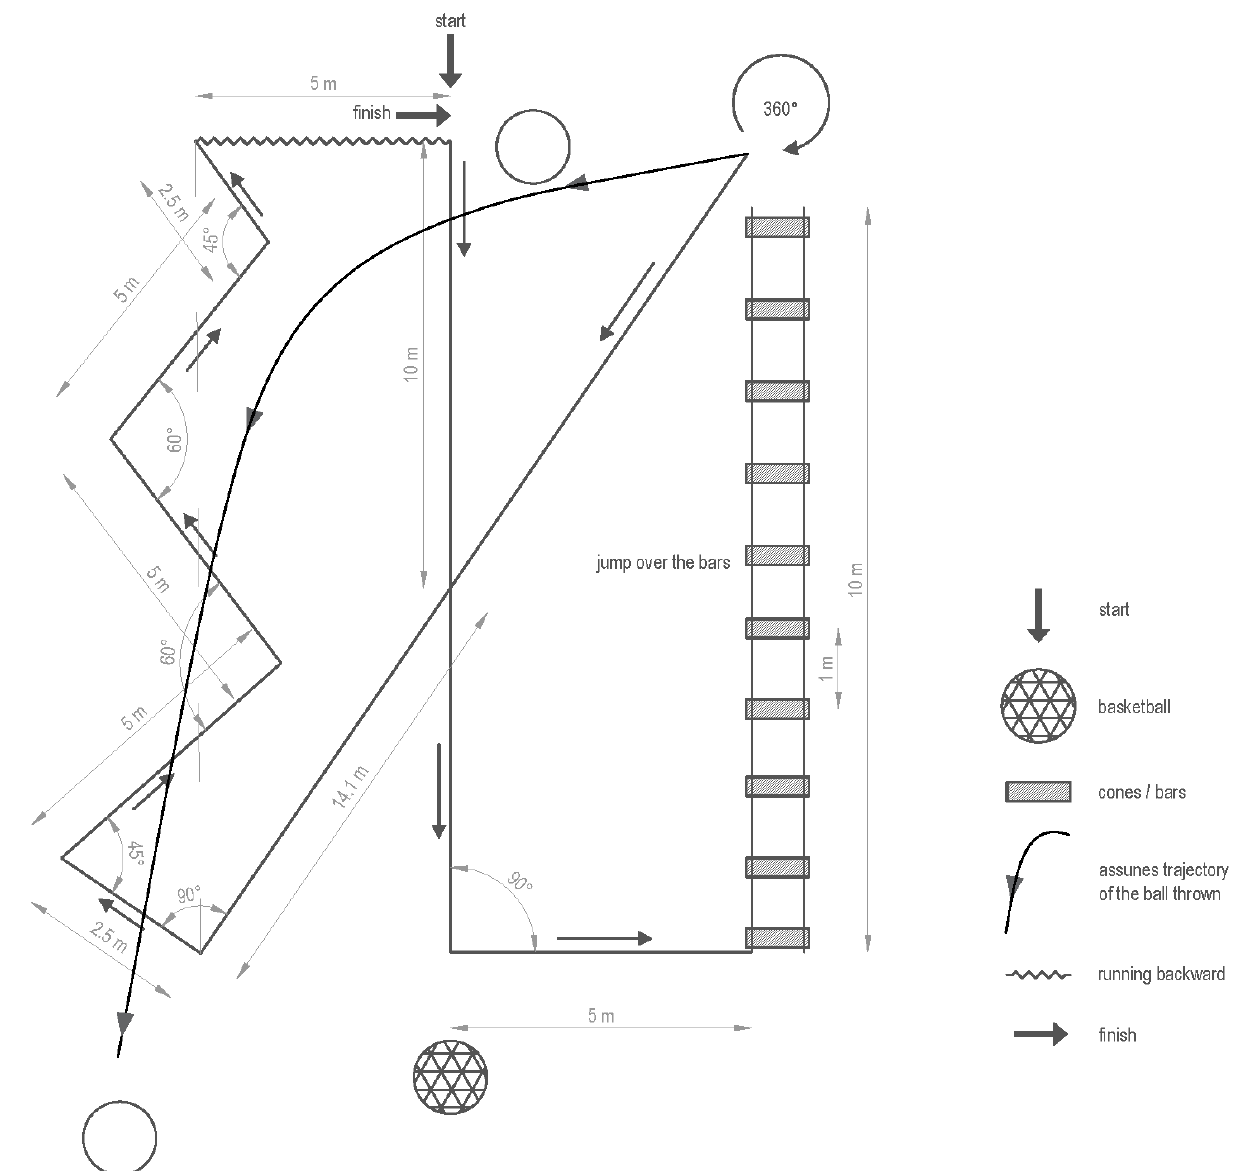
Figure 11. Basketball-specific Multicomponent Agility Test; adapted and edited from [36] .